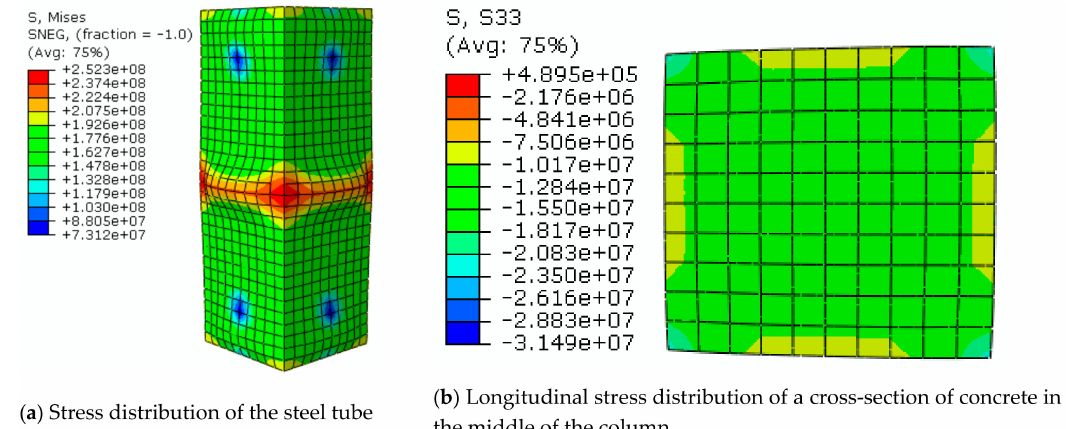
Figure 10. Stress distribution nephogram of steel tube and concrete.